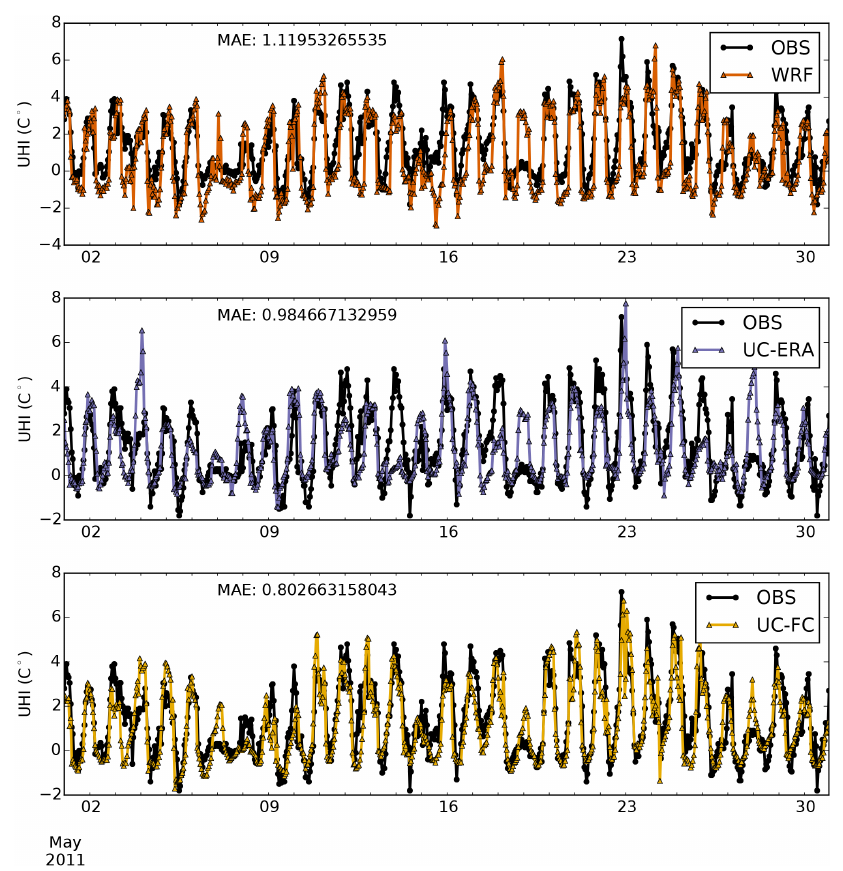
Figure 6. Hourly time series of the 2m temperature difference between the urban and the rural locations for May 2011, for WRF (top), UC-ERA (middle) and UF-FC